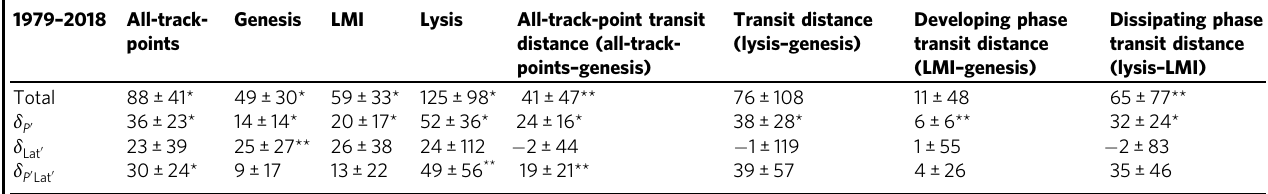
Linear trends (km/decade) in annual-mean latitude and its three seasonality contributing terms ( δ P 0 , δ Lat 0 and δ P 0 Lat 0 ) for western North Paci fi c TC track metrics, in the ERA-Interim TC dataset, over the satellite era (1979 – 2018). The El Niño Southern Oscillation and Paci fi c Decadal Oscillation effects have been removed with a multivariate regression before estimating the trend; ± represents the 95% con fi dence interval of trend value. * indicates signi fi cant trend at the 95% con fi dence. ** indicates signi fi cant trend at the 90% con fi